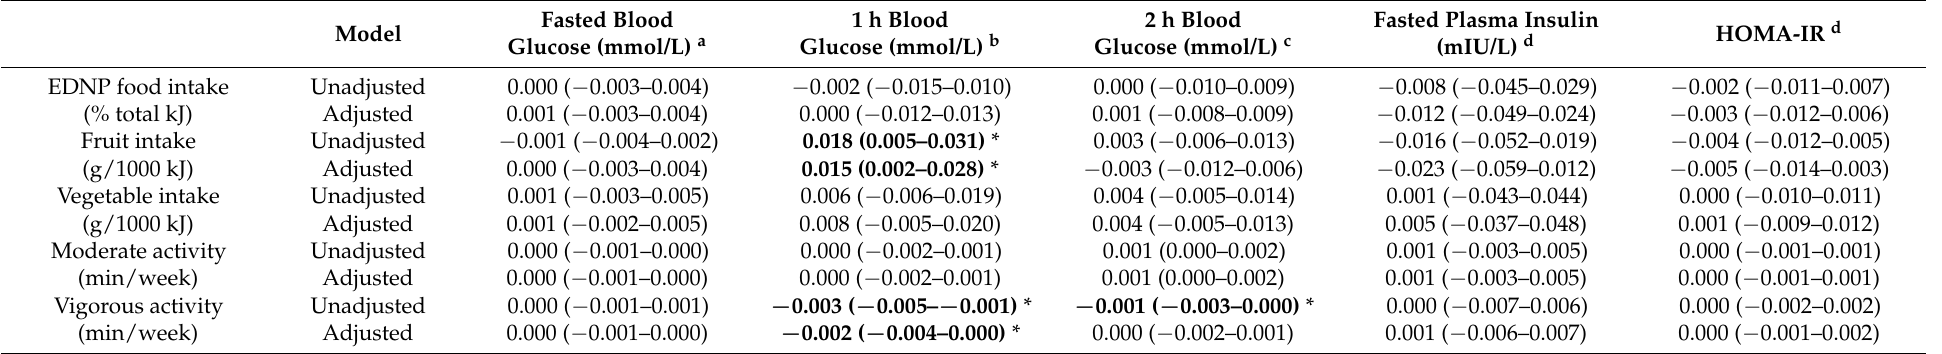
Table 5. Multiple regression of metabolic outcomes with diet and physical activity variables. ß-Coefficient (95% CI)